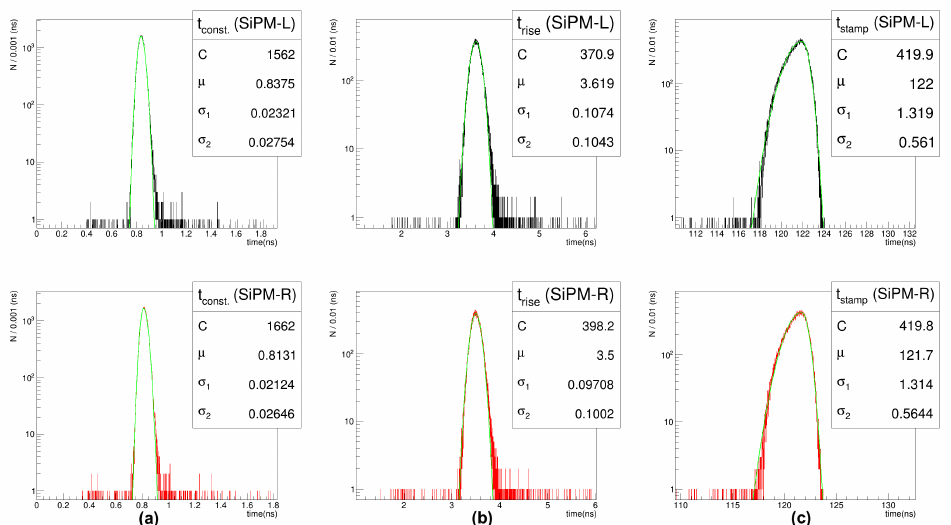
Figure 7. Measured timing information from both SiPMs for the Eljen-228 scintillator. Each distribu- tion shows the time constant ( a ), the rise time ( b ) and the time stamp ( c ) tagged at a given constant fractional threshold of 0.2 (20%). The data are fitted with an asymmetric Gaussian function defined in Equation